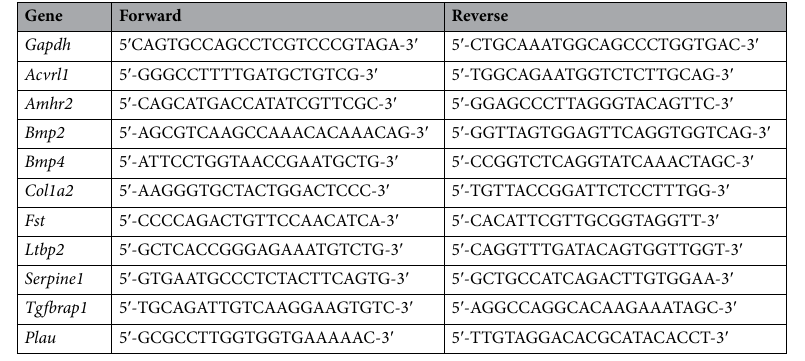
Table 1. Primers used for